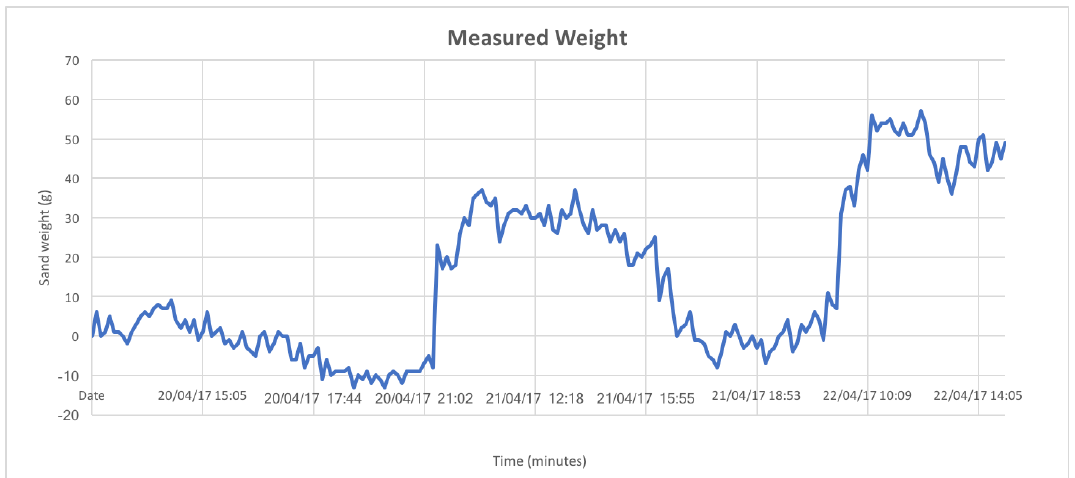
Figure 10. Collected sand weight during the data acquisition campaign carried out on the beach of Marina di Tirrenia.